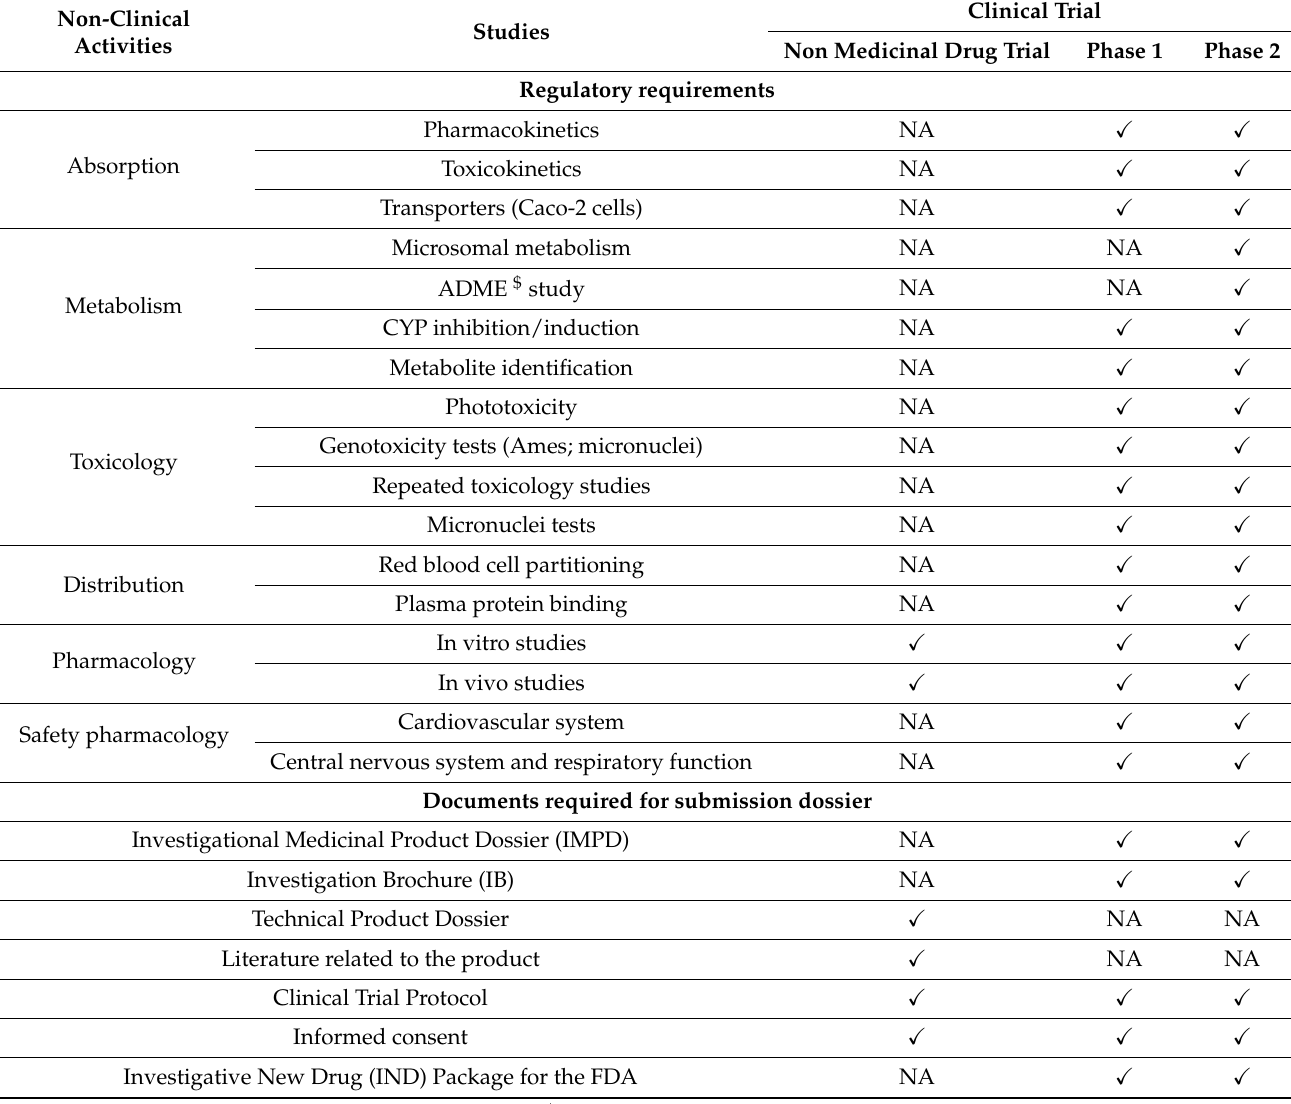
Table 5. Non-clinical regulatory requirements and submission dossier for clinical trial approval.